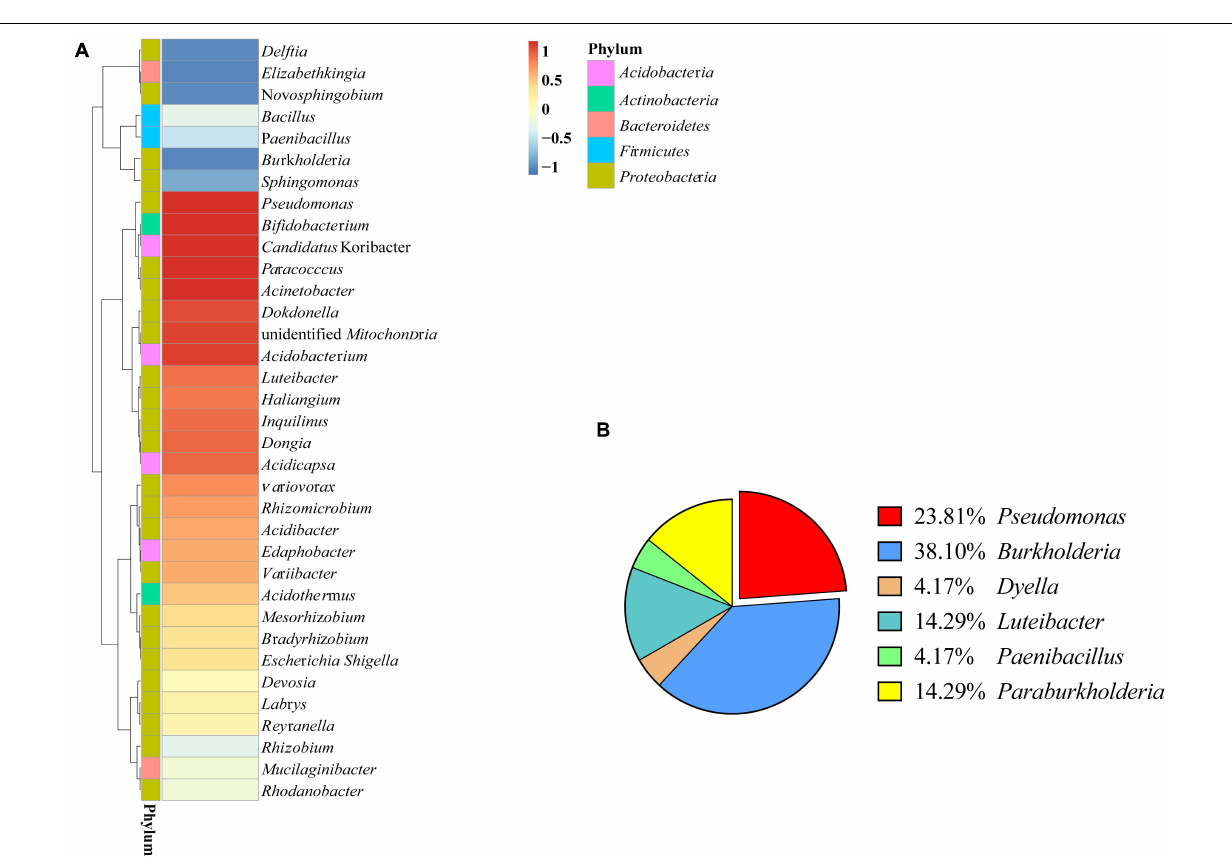
provides phenotypic characteristics ( Supplementary Table 2 ) also confirmed that strain ZL8 belongs to Pseudomonas